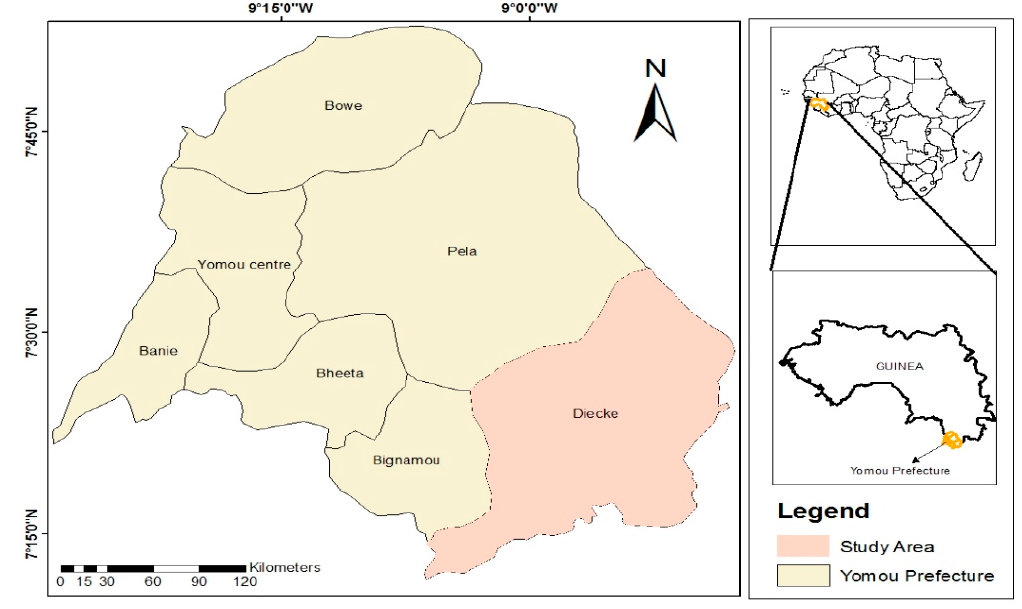
Figure 1. Location of study site.